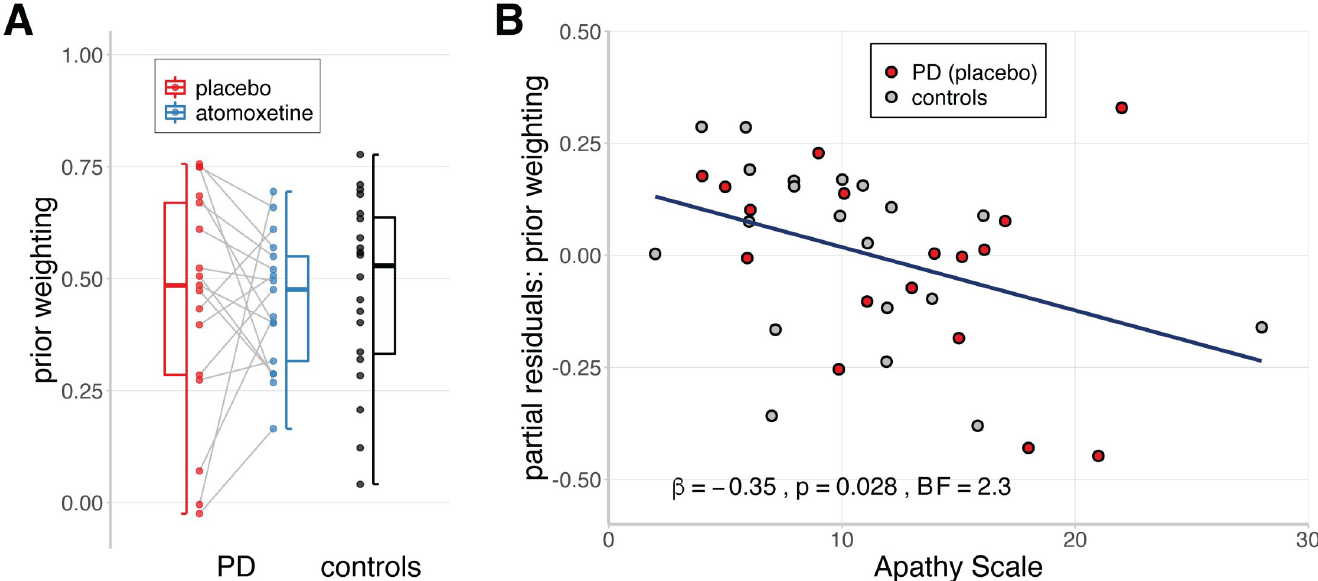
Fig 2. Prior weighting and apathy. A) Estimates of prior weighting, obtained through a linear mixed effects model of estimation errors against performance errors. For the Parkinson’s disease group, the grey lines indicate within-subject change in prior weighting from placebo to atomoxetine. Box-plot elements: centre line, median; box limits, first and third quartiles; whiskers, most extreme observations (all within 1.5 × interquartile range from the box limits). B) The relationship between apathy and prior weighting, adjusted for the effects of group and task performance variability (i.e., partial residuals). Note that observations with identical questionnaire scores were horizontally jittered to avoid overlaid